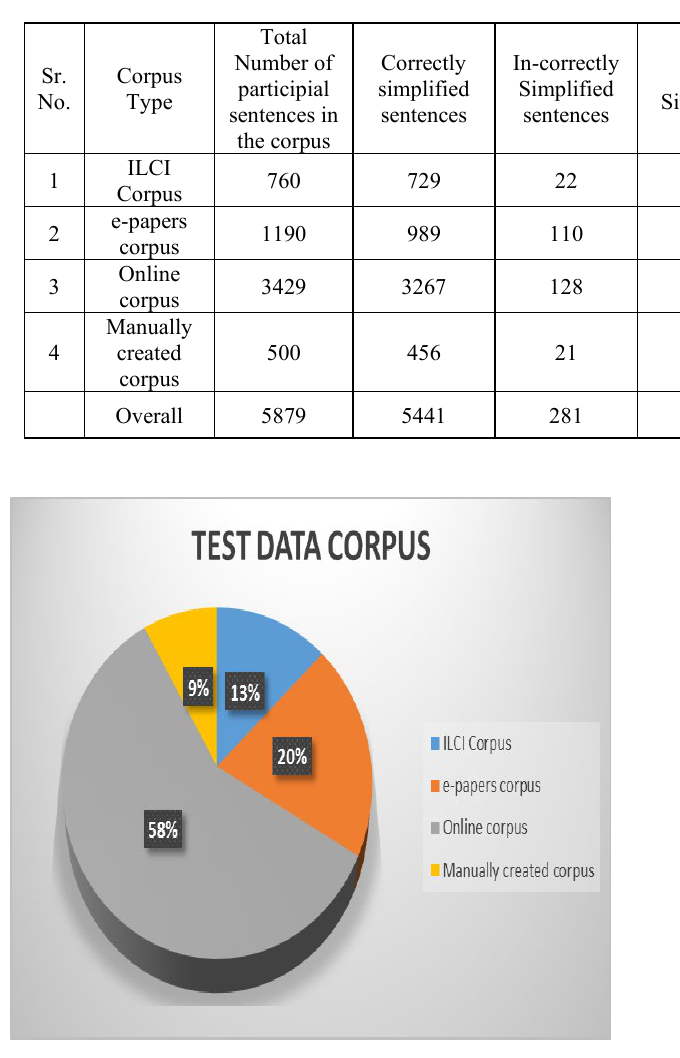
Figu re 6. Details of test corpus used for testing Figu re 7. Sentence Simplification